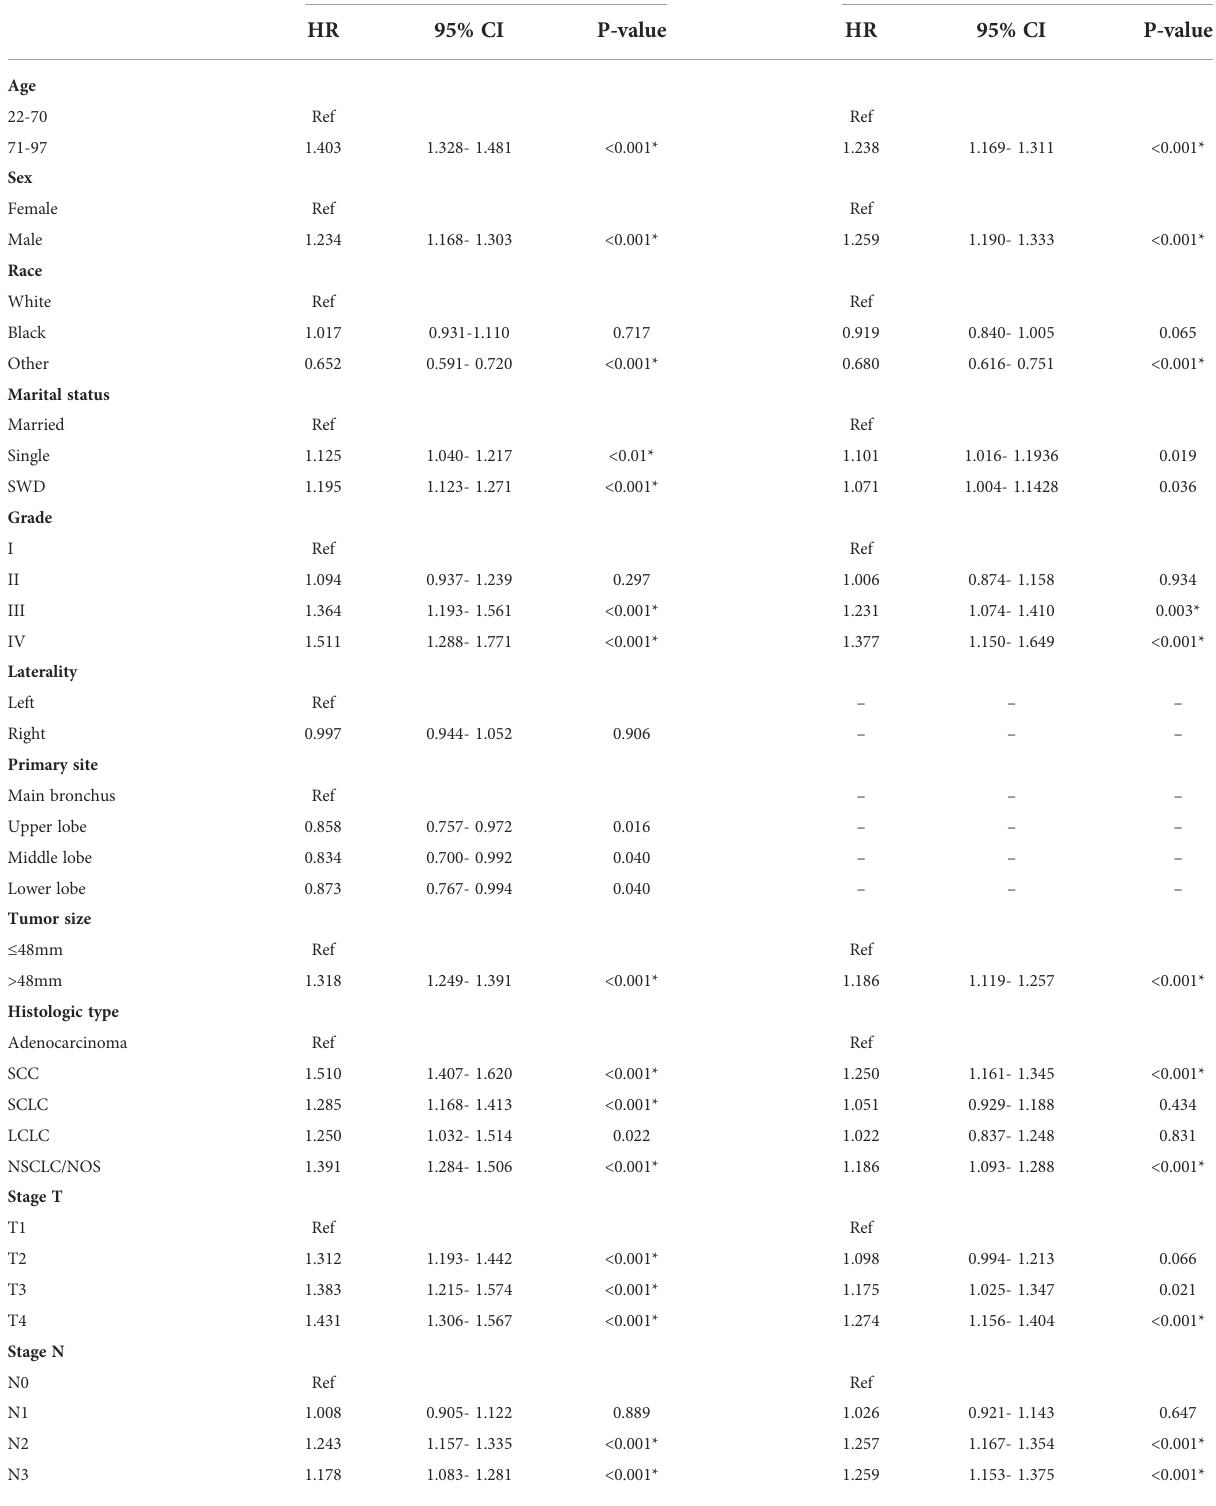
TABLE 2 Univariate and multivariate Cox proportional hazards regression analysis of prognosis of lung cancer with bone metastasis in the training